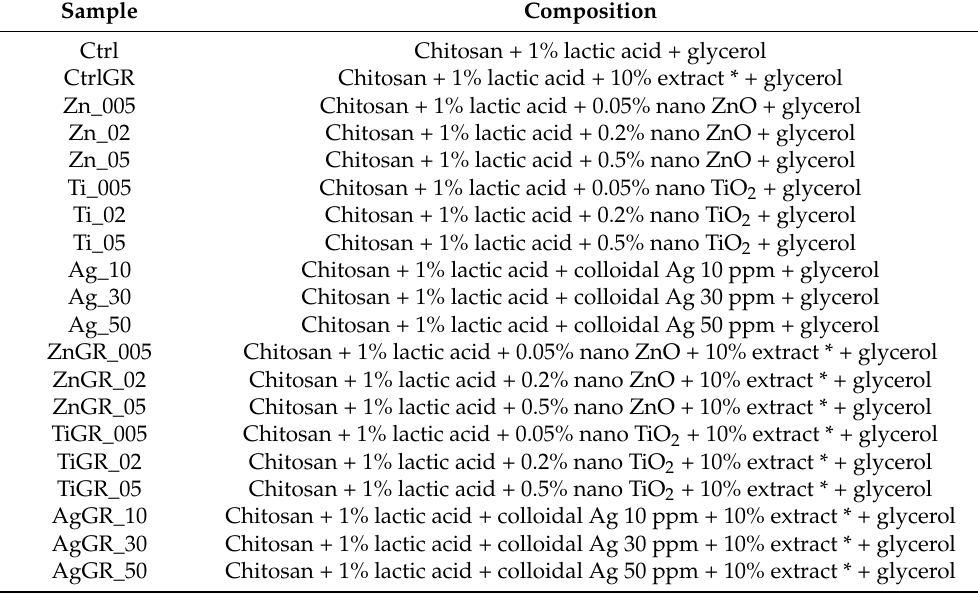
Table 1. Composition of the coatings